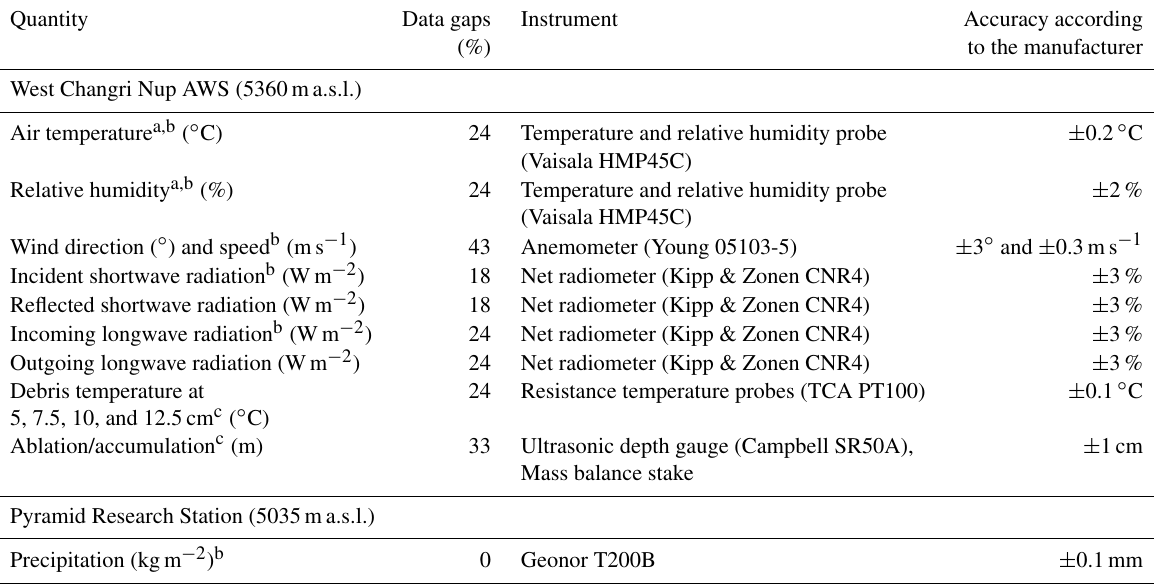
Table 2. Meteorological quantities and debris characteristics measured by the AWS on West Changri Nup glacier on 6 December 2012, 09:15–28 November 2014, 07:45UTC. All sensors give values every 30min; these values are 30min averages of data with 30s scanning intervals for all values except the ultrasonic SR50 and wind direction, which are sampled every 30min. The Kipp & Zonen CNR4 net radiometer measures the spectral band 0.305 < wavelength ( λ ) < 2.8µm for shortwave radiation and 5 <λ< 50µm for longwave radiation. The SR50 senses surface height changes and, thus, can indicate the occurrence of ablation or accumulation but not measure it